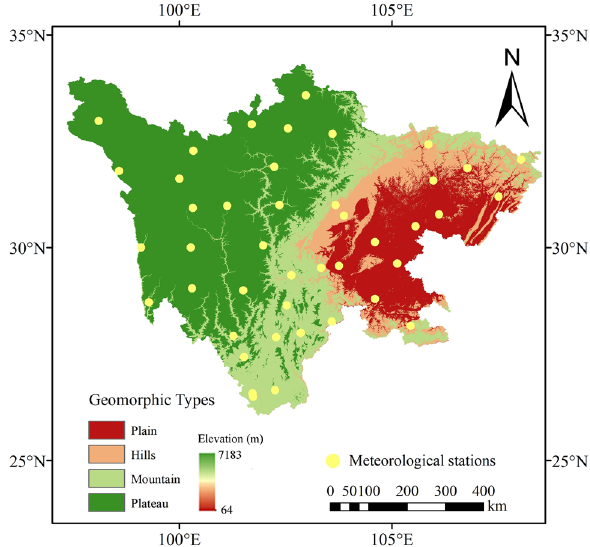
Figure 1. The location of the Sichuan Province and the distribution of meteorological stations. (The figure was generated by ArcGIS 10.6 software, https ://deskt op.arcgi